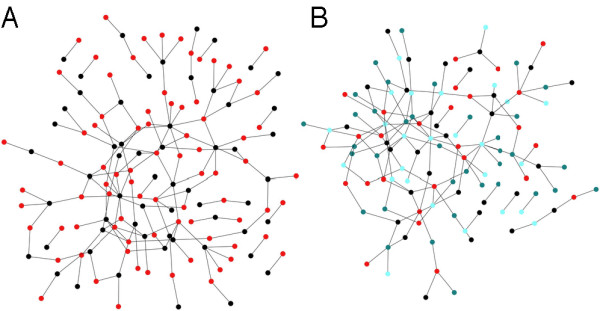
Bipartite and k-partite graphs. (A) Bipartite graph, nodes from one group colored in red, nodes from the other group colored in black, PN/PE = 0.3, p = 0.85, q = 0.75, PD = 0.0. The graph was grown for 1,000 iterations of the algorithm, with undirected edges. (B) Graph grown with the same parameters as (A), but for k = 4.